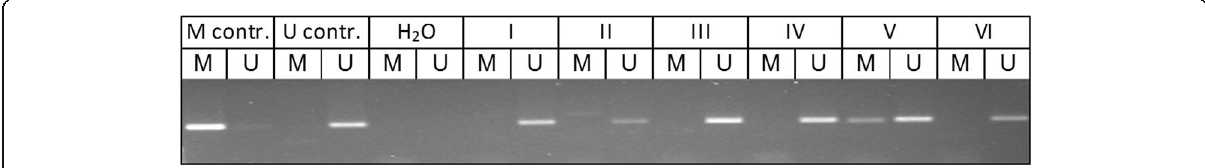
Fig. 1 Analysis of STAT3 gene MS-PCR products on 2% agarose gel. M indicates methylated alleles, U unmethylated alleles. M cont. – positive methylation control (Standard Bisulfite Converted Universal Methylated Human DNA), U cont. – negative methylation control (normal human peripheral lymphocytes), H 2 O – water control, I-VI designate PA